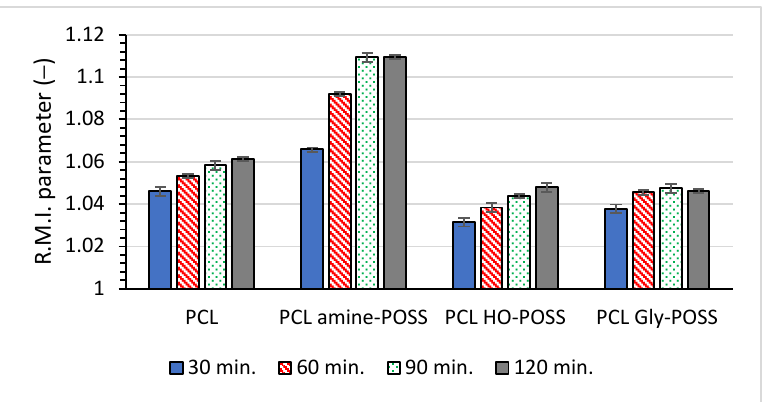
Figure 8. Calculated from the complex viscosity plot R.M.I. parameters for PCL samples after thermo-oxidative treatment.